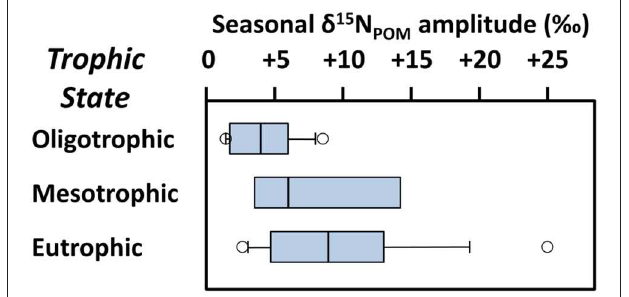
FIGURE 8 | Lake trophic state vs . amplitude of annual shifts in δ 15 N of organic matter associated with seasonal change in 36 lakes: oligotrophic ( n = 13), mesotrophic ( n = 5), eutrophic ( n = 18). Data are collated by Gu (2009).